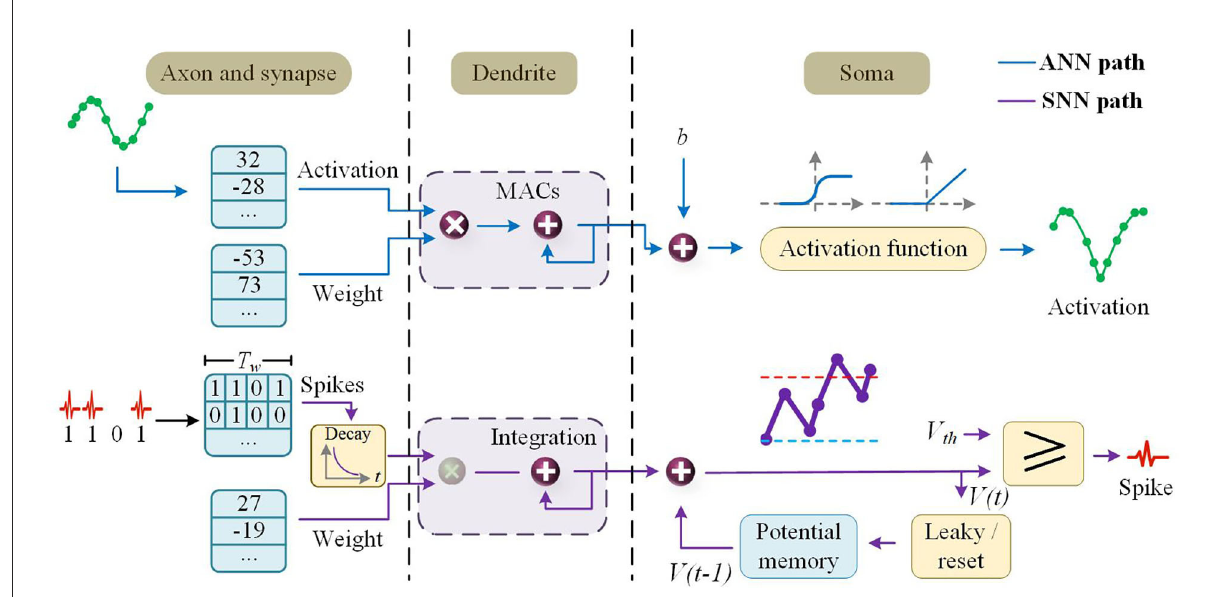
FIGURE5 Design of the Tianjic chip and its specific processing flow in ANN and SNN mode.